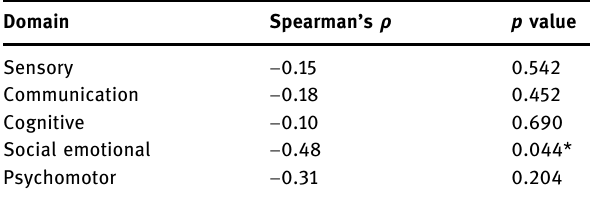
Table 6: Correlations between initial scores and number of